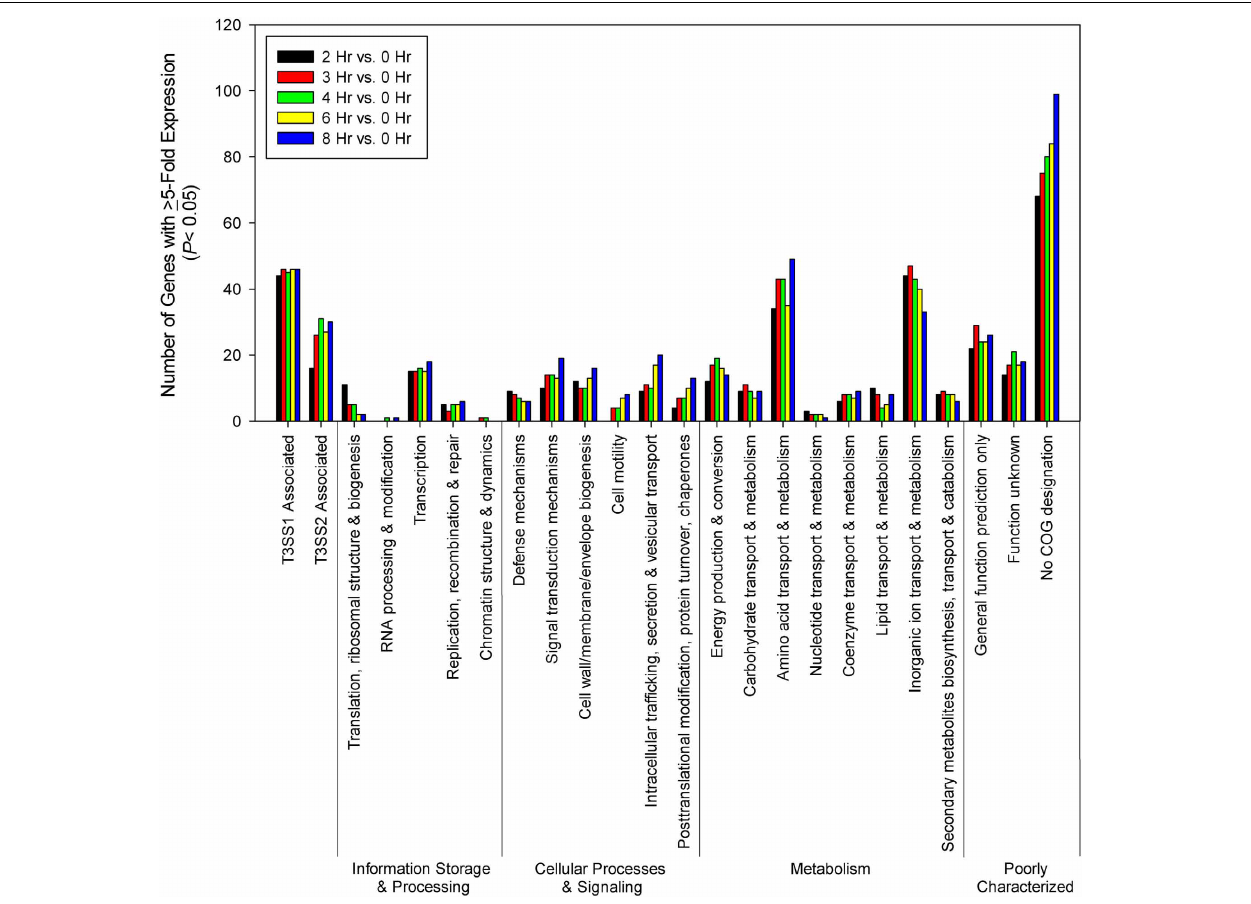
FIGURE 6 | Time points during infection of HeLa cells ( n = 2 replicates) were compared to 0h (pre-infection). Genes were screened for ≥ 5-fold increase in expression ( P < 0 . 05) and grouped by COG designation and association with T3SS1 ( vp1656 — vp1702 ; vpa0450 — vpa0451 ) or T3SS2 ( vpa1314—vpa1378 ).